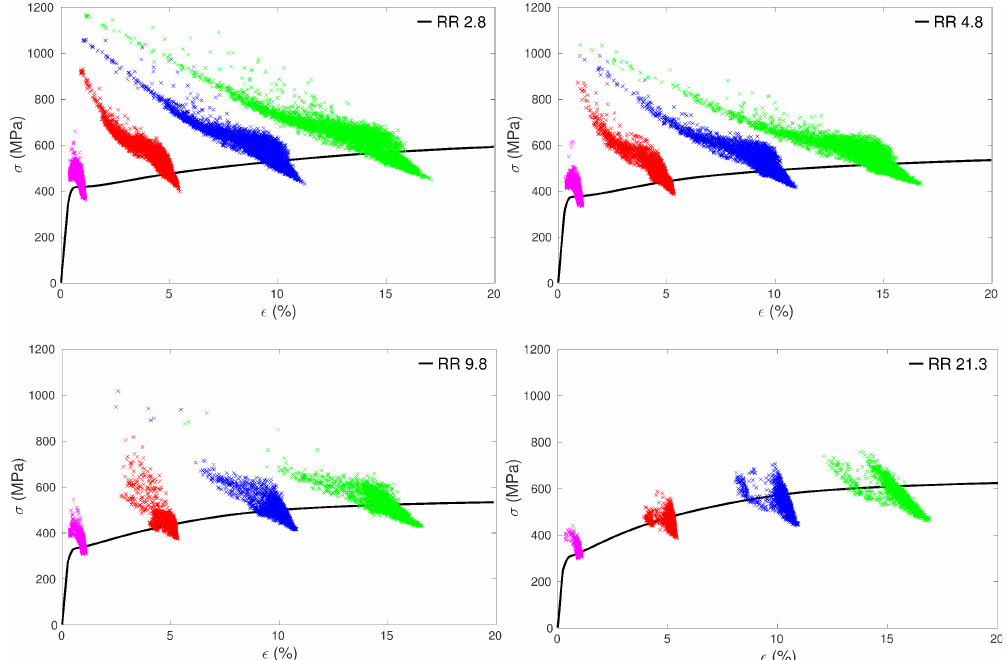
Figure 8. Distribution of predicted tensile stress–strain relationships for each grain at 1% (magenta), 5% (red), 10% (blue) and 15% (green) of macroscopic strain for specimens RR 2.8, RR 4.8, RR 9.8 and RR 21.3. The corresponding model tensile curve is superimposed on each plot (black thick